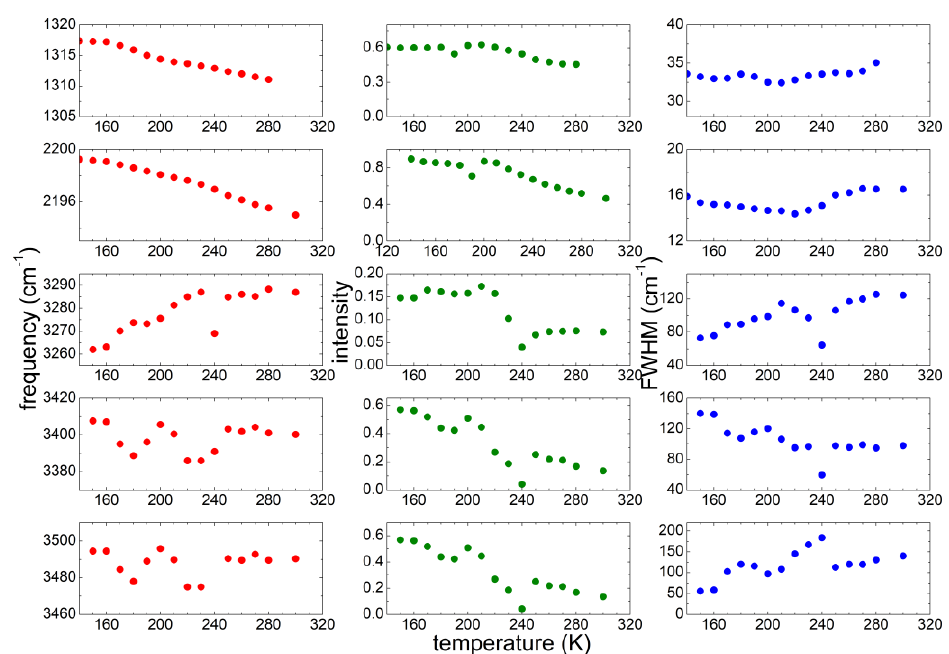
Figure 7. Temperature dependence of the parameters of the most significant absorption lines of PYR 14 -DCA + H 2 O measured on heating from 160 up to 300 K.